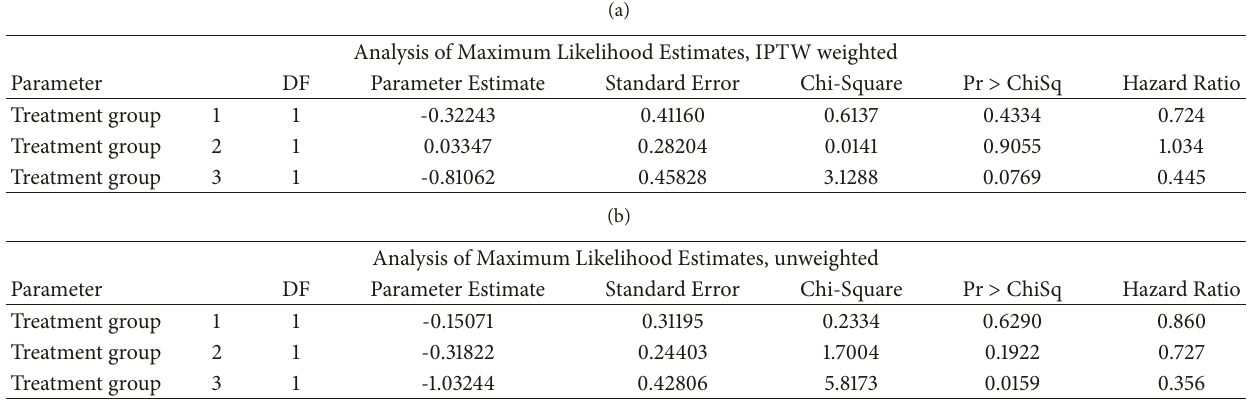
Table 3: Marginal structural Cox model of the time to EDSS